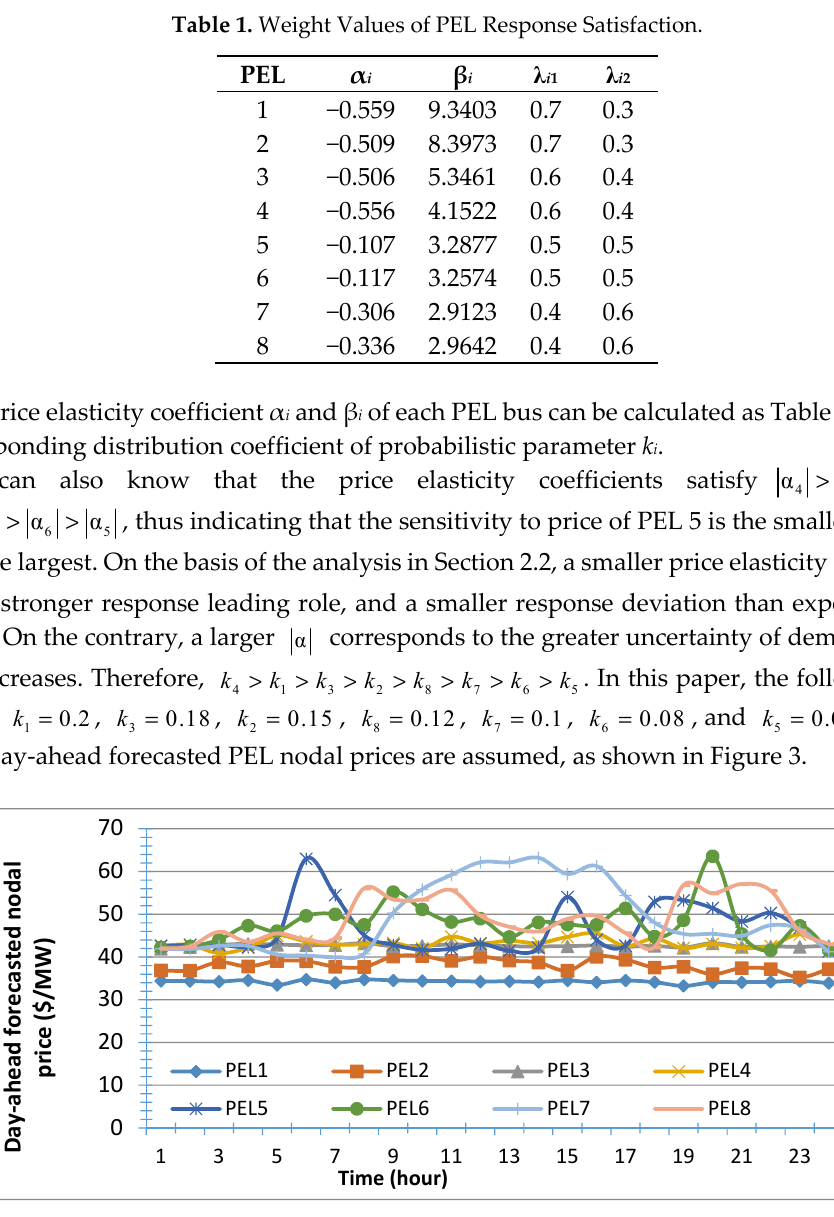
Figure 3. Day-ahead forecasted PEL nodal